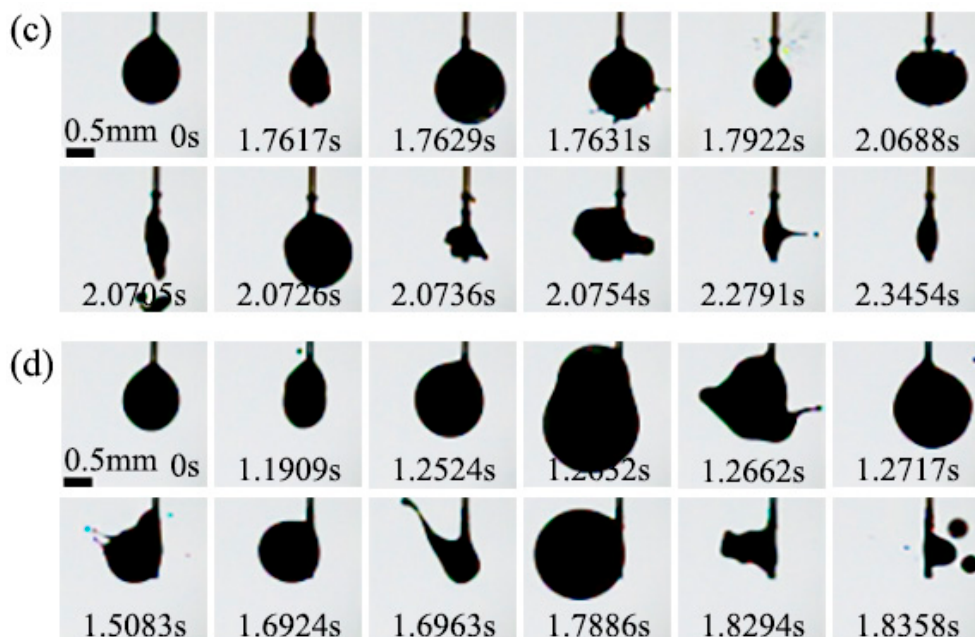
Figure 12. Microexplosion of Al/JP-10/oleic acid nanofluid fuel at different Al concentrations. ( a ) 1.0 wt.%, ( b ) 2.5 wt.%, ( c ) 5.0 wt.%, ( d ) 10.0 wt.%.